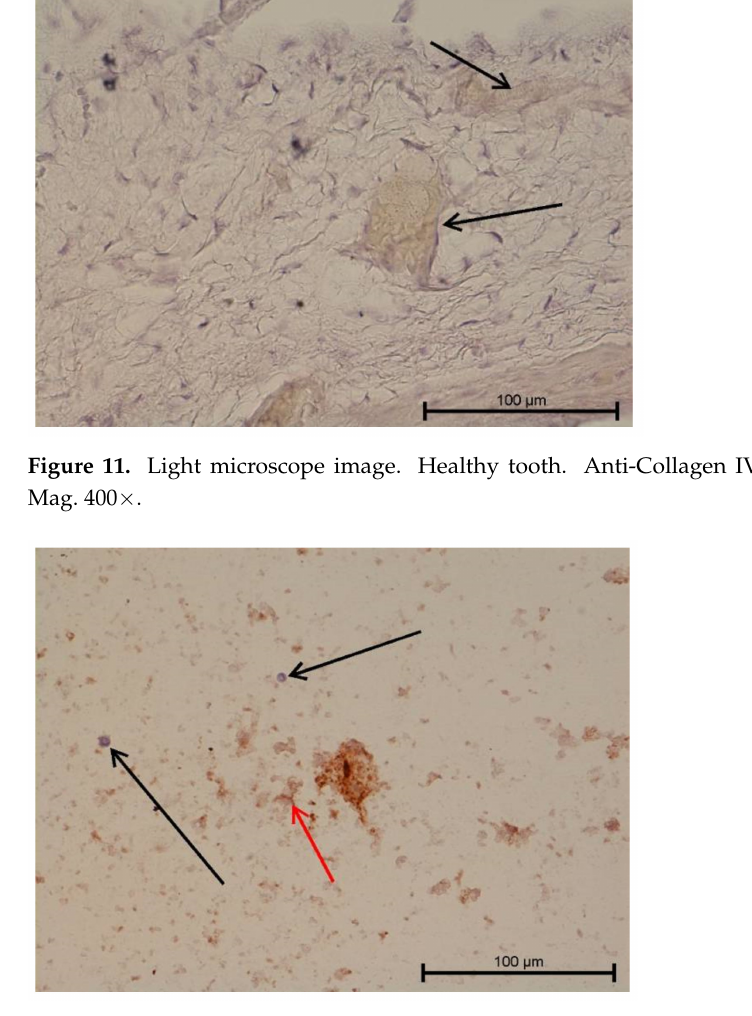
Figure 12. Light microscope image. Carious tooth. Anti-Collagen IV—positive (red arrow). Severe inflammation neutrophils present (black arrow). Mag. 400 ×